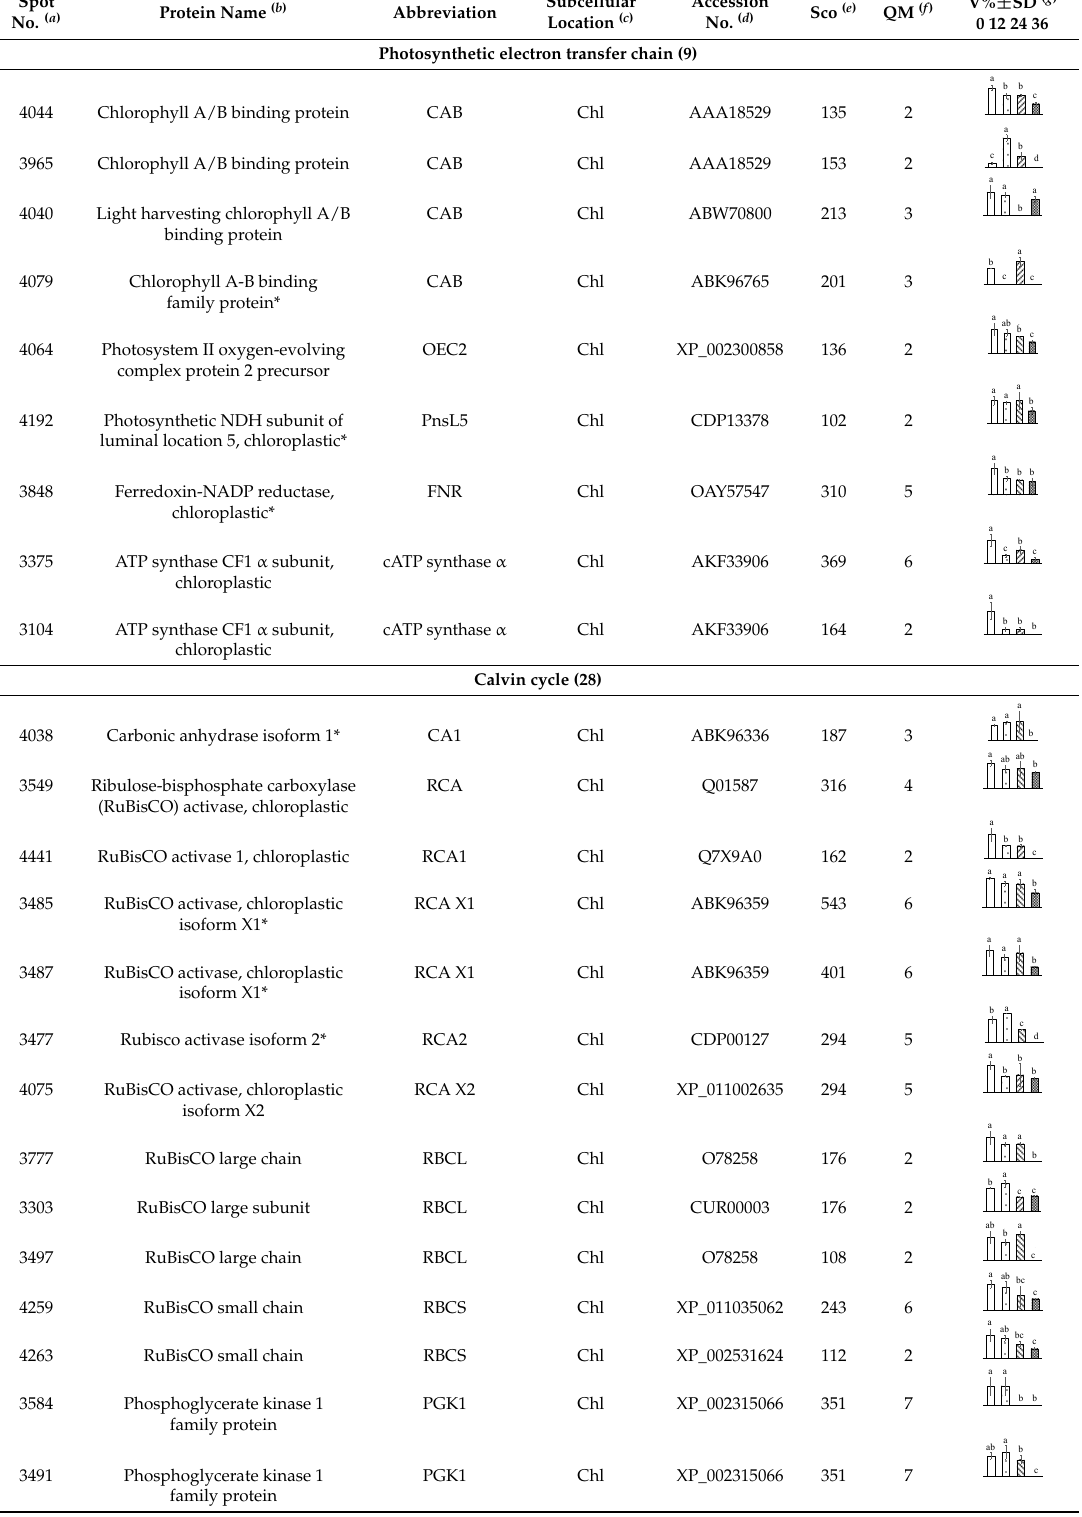
Table 1. H 2 O 2 -responsive proteins in leaves of Populus simonii × Populus nigra .